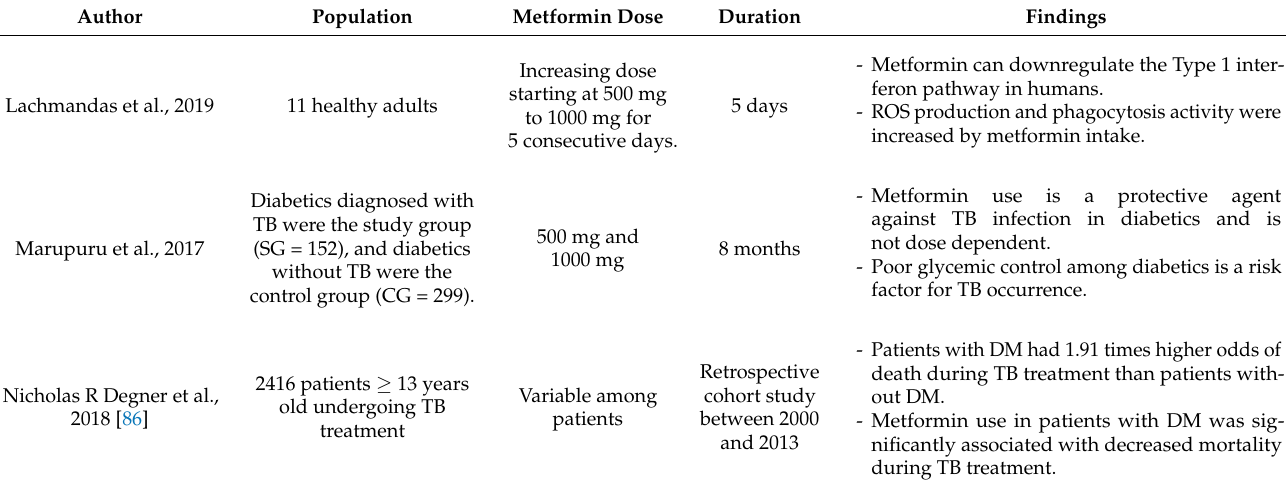
Table 2. Overview of major clinical studies in regard to